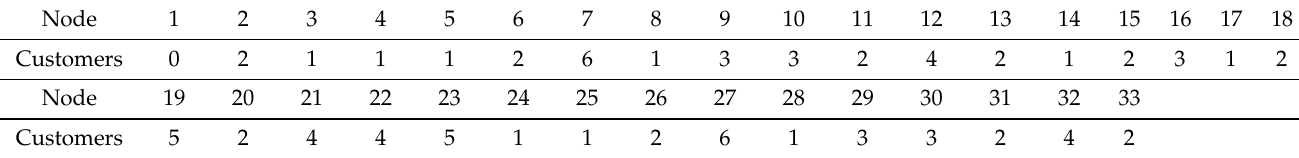
Table 2. LV number of